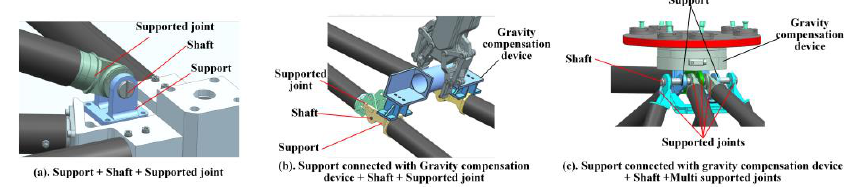
Figure 7. Typical hinge forms of LSDM.